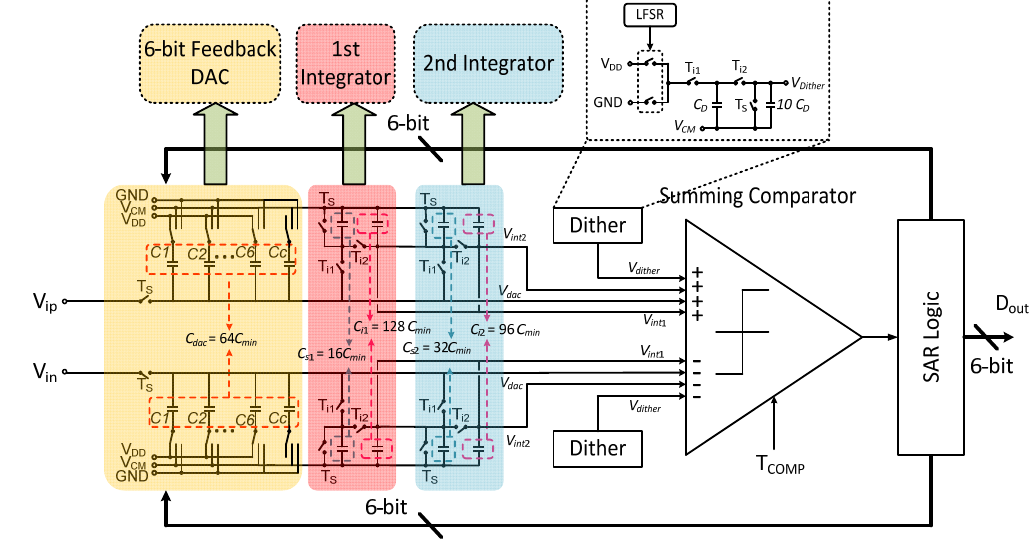
Figure 10. Second-order NS ∆ - Σ SAR ADC with dither injection.